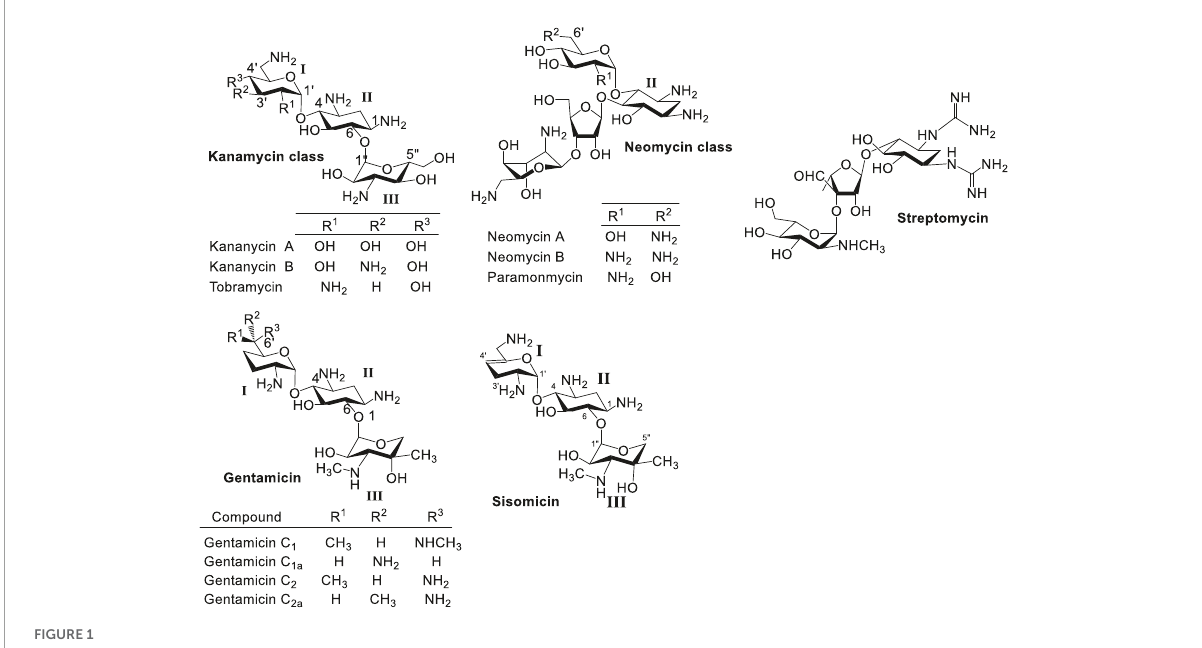
FIGURE1 Structures of natural AGs.